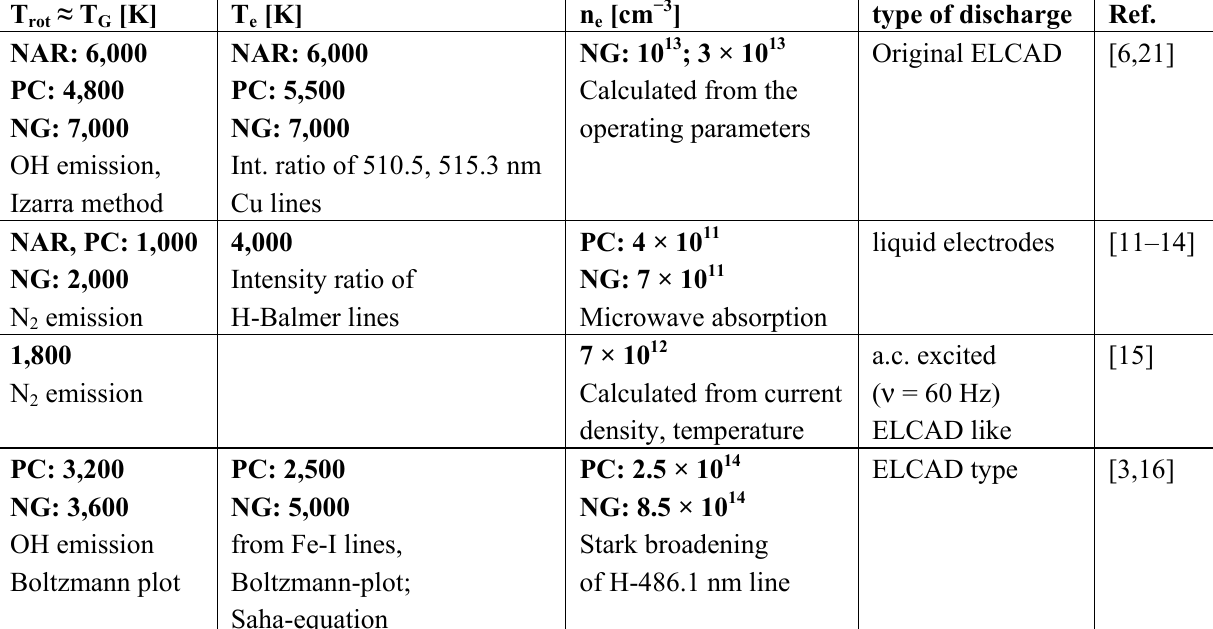
Table 1. The published T density values showing the measuring place (NG = negative glow, PC = positive column, NAR = near anode region), the determination method, the type of discharge and the references.